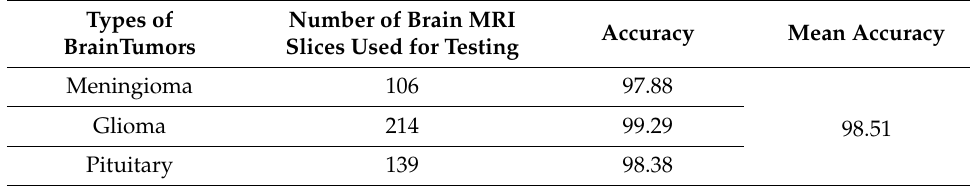
Table 3. Accuracy Percentage of Each Types of Tumors obtained by Proposed